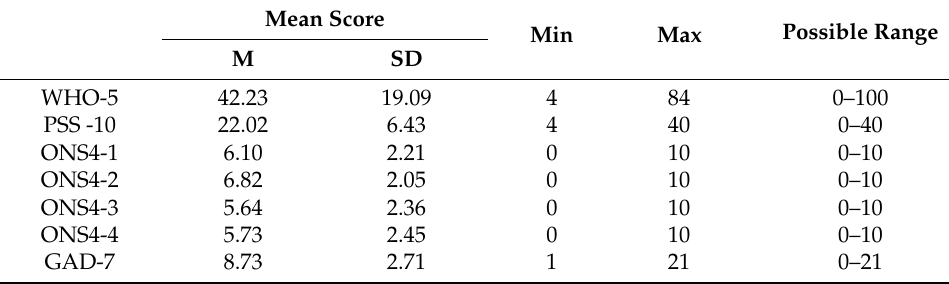
Table 4. Clinical characteristics at baseline (N =